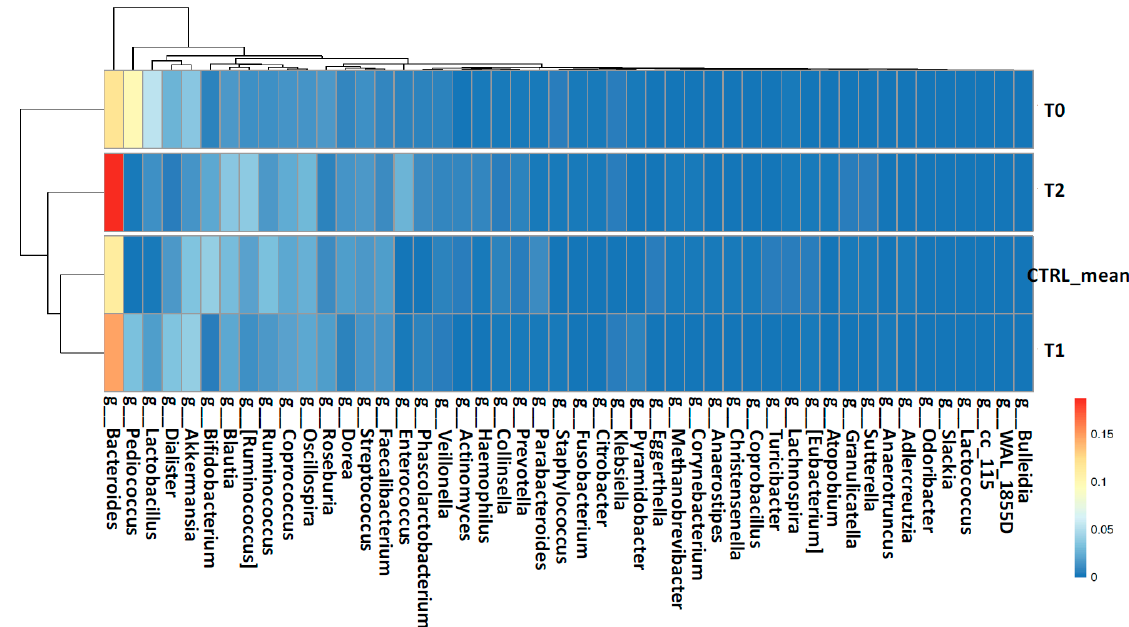
Figure 4. Heatmap with hierarchical clustering based on families’ (L5) abundances. The colors in the heatmap refer to the family’s abundance, according to the color scale on the right.